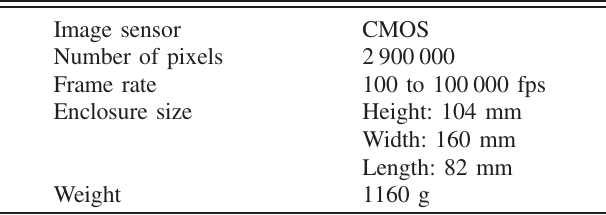
TABLE IV. Specifications of the high-speed camera HAS-D3M used in this